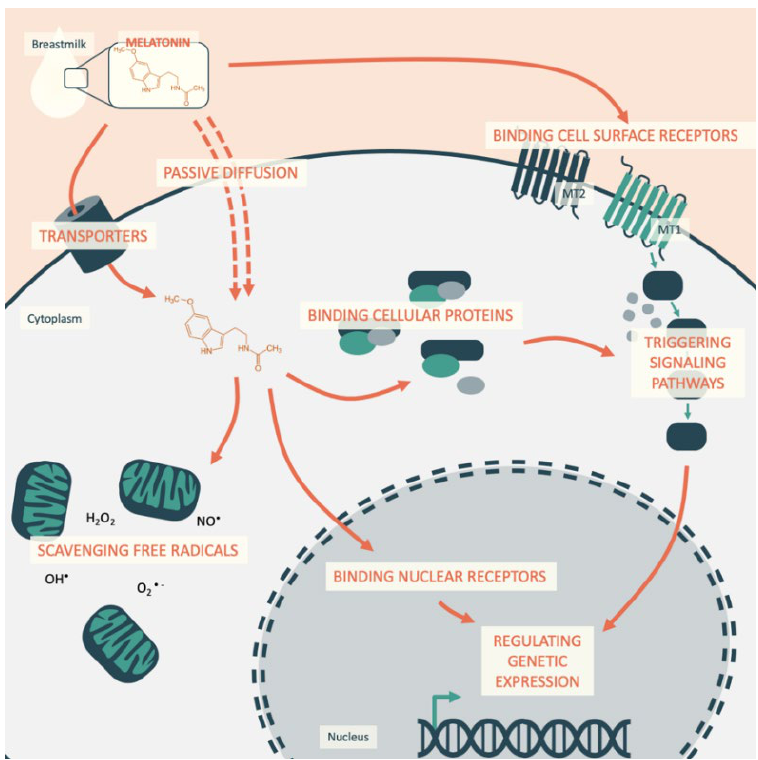
Figure 1. Melatonin cellular pathways in cardiomyocytes physiology.